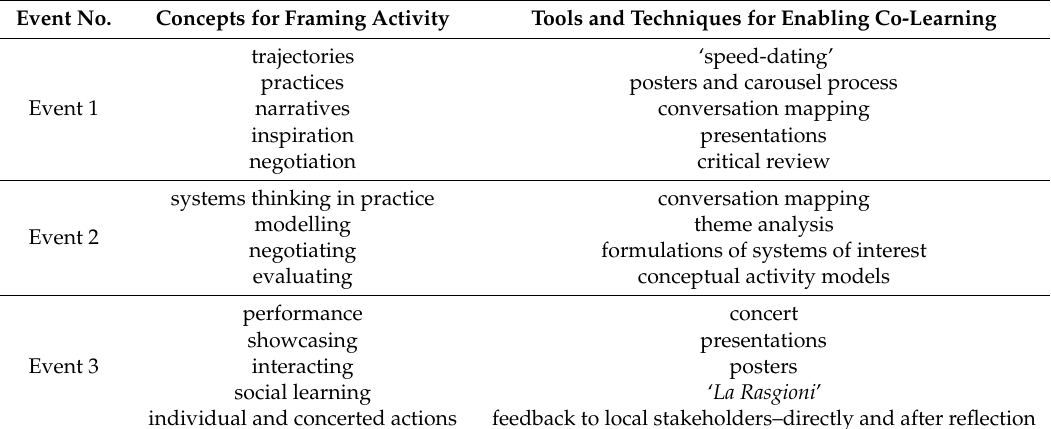
Table 1. Concepts and tools used in the Governance Learning